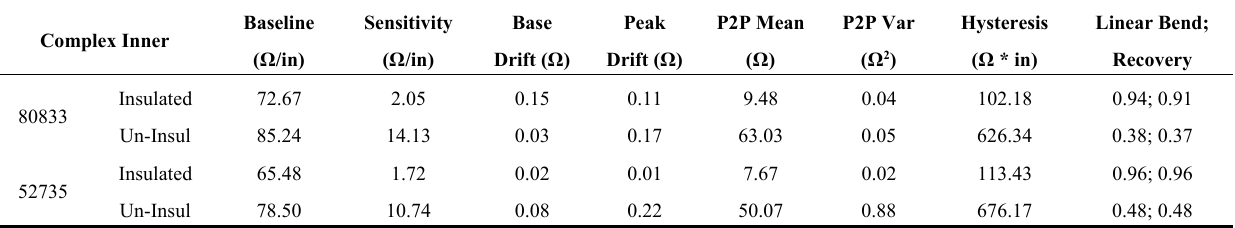
Table 3. Complex inner bend parameters for stiffest (80833) and least stiff (52735) fabric, both in the insulated and un-insulated sensor